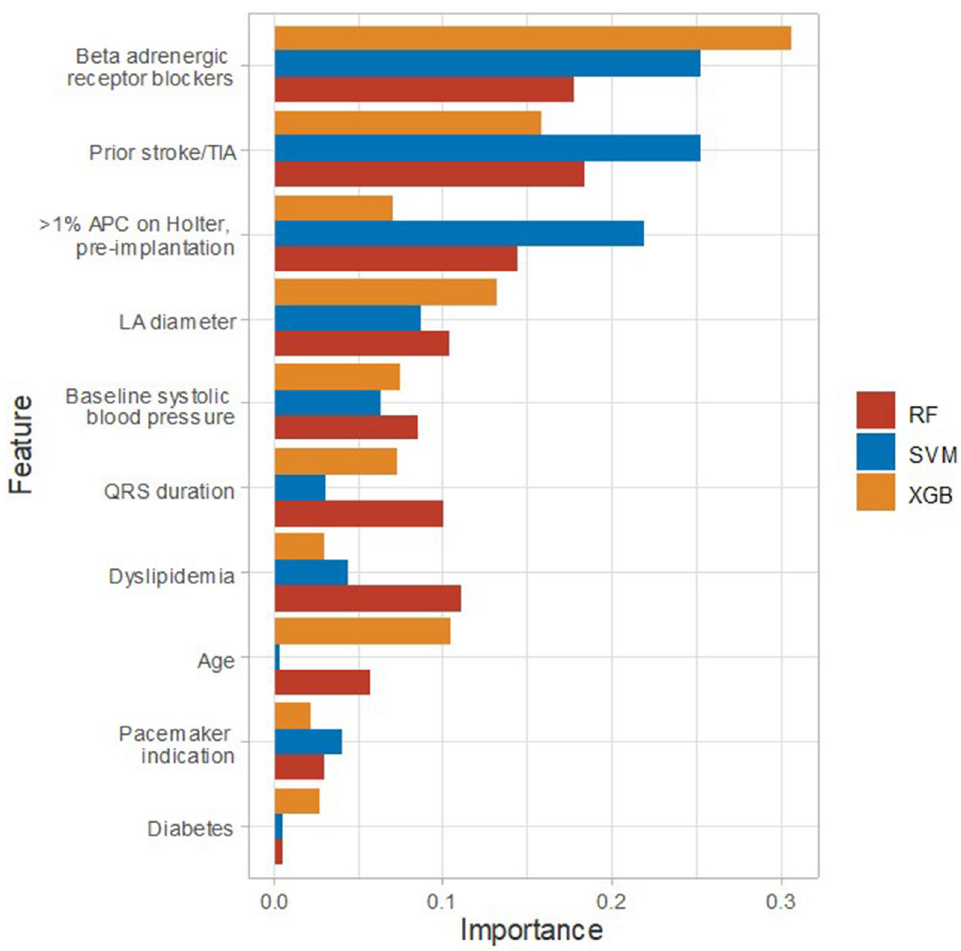
Figure 4. Feature importance index plot for each